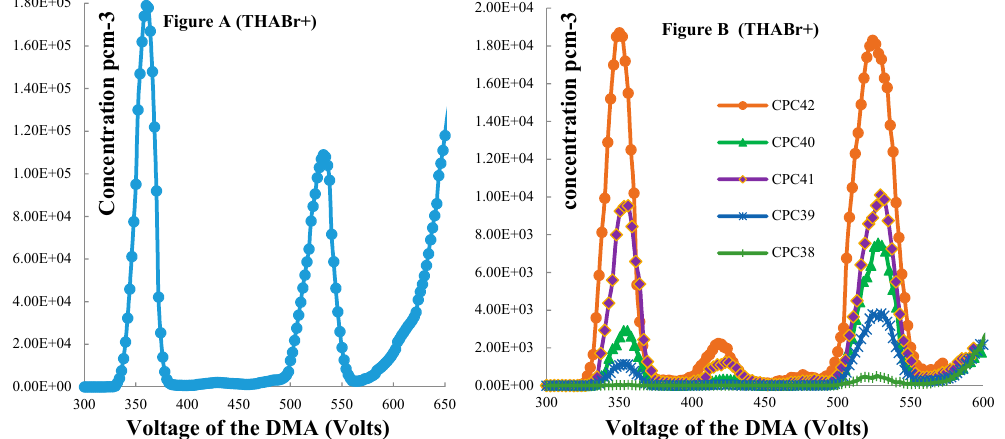
Figure 3. Mobility diameter distribution measurements of the tetraheptylammonium bromide as a function of the voltage of the DMA. Aerosol electrometer (AEM) was in use in the results given in the Figure ( A ) (left panel). Variable saturator temperatures CPC was in use for the results given in the Figure ( B ) (right).